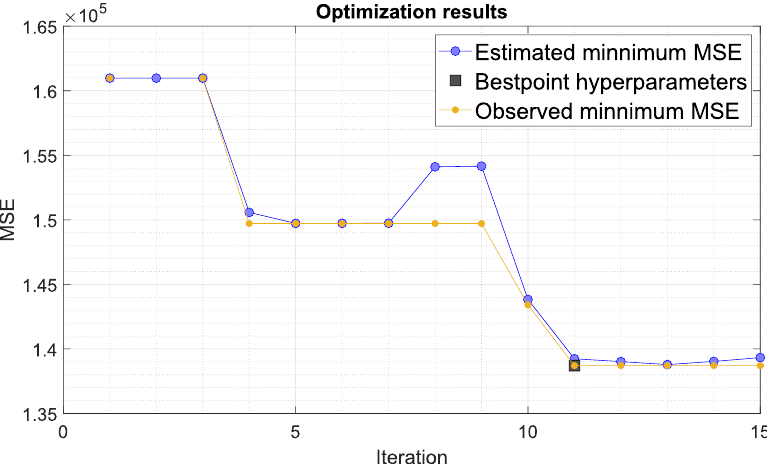
Figure 8. Optimization of the hyperparameters of the neural algorithm